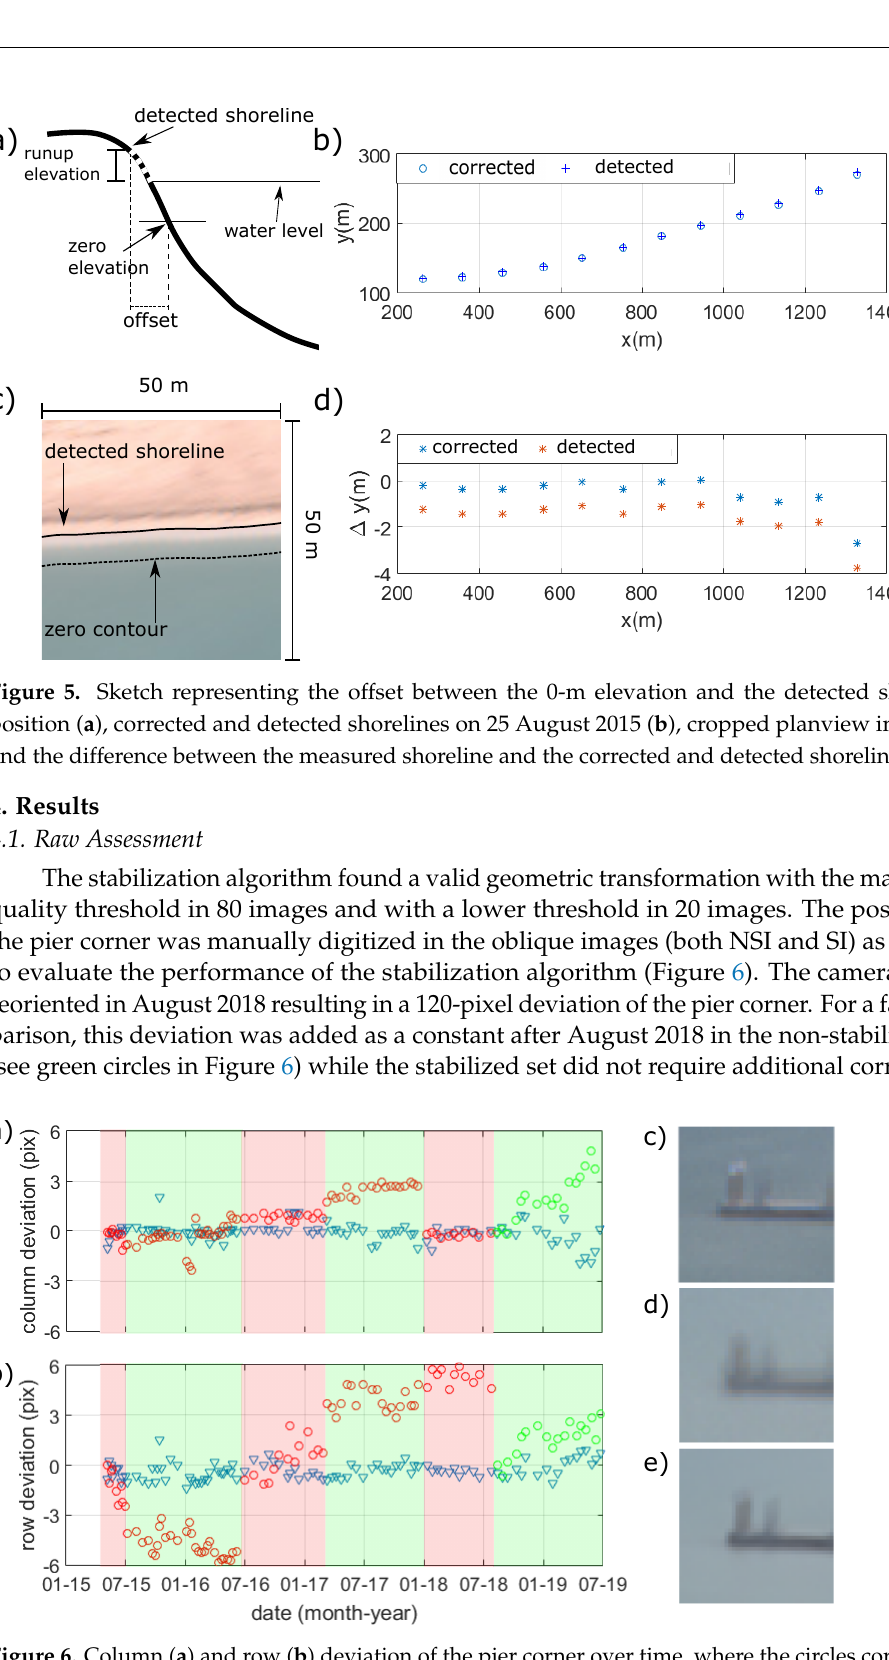
Figure 6. Column ( a ) and row ( b ) deviation of the pier corner over time, where the circles correspond to the non-stabilized images and the triangles to the stabilized images. The shading transitions represent calibration updates to create the non-stabilized planviews, the stabilized data set uses only one calibration. Zoom of the pier on 14 May 2017 ( c ), the average until August 2018 of the non-stabilized set ( d ), and the average until July 2019 of the stabilized data set ( e